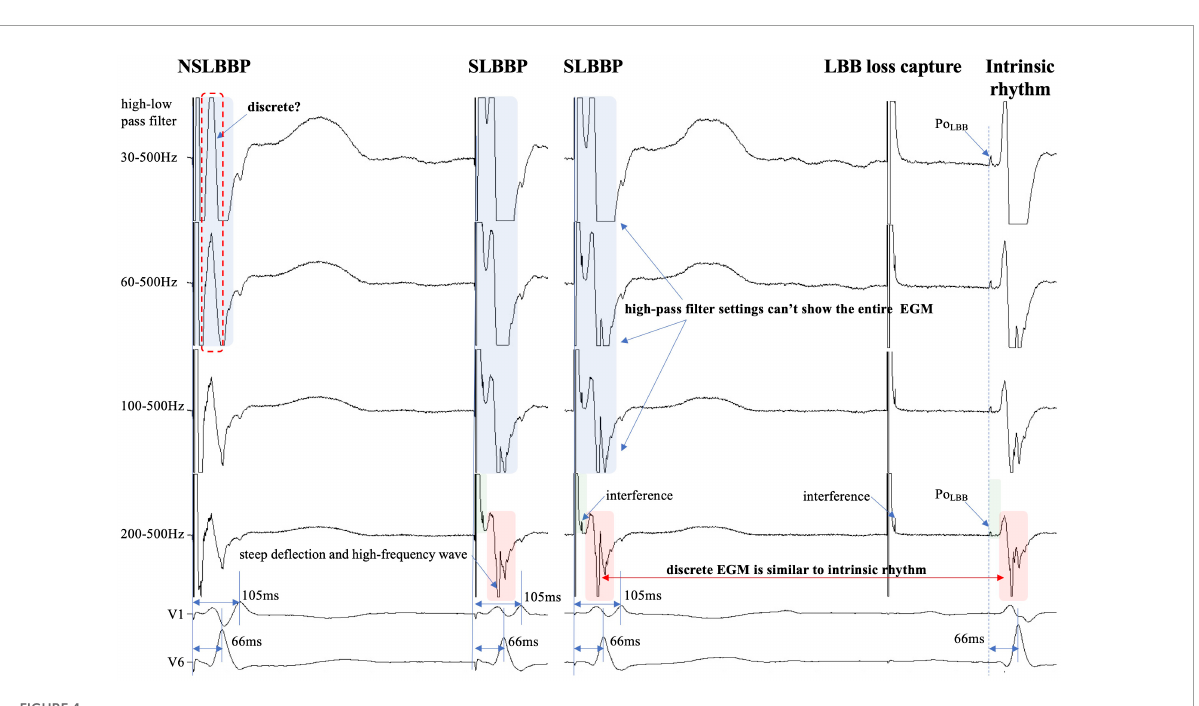
FIGURE4 Discrete ventricular components cannot be accurately identified because the entire EGM morphology cannot be displayed (blue rectangle). Steep deflection and high-frequency discrete local ventricular EGM morphology are similar to ventricular EGM morphology of intrinsic rhythm (red rectangle). Isoelectric interval is affected by pacing artifacts (green rectangle). Po LBB can be observed at different high-pass filter settings (blue dashed line). Abbreviations as in Figure 1